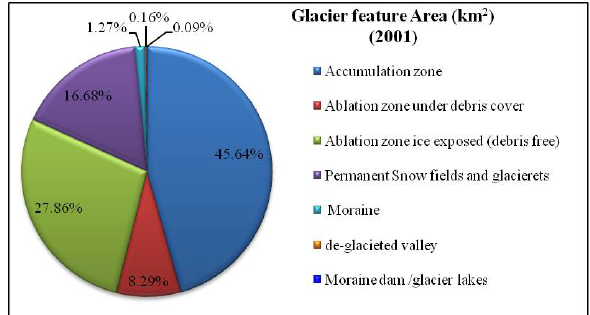
Figure 8: Percent glaciated area under major morphological